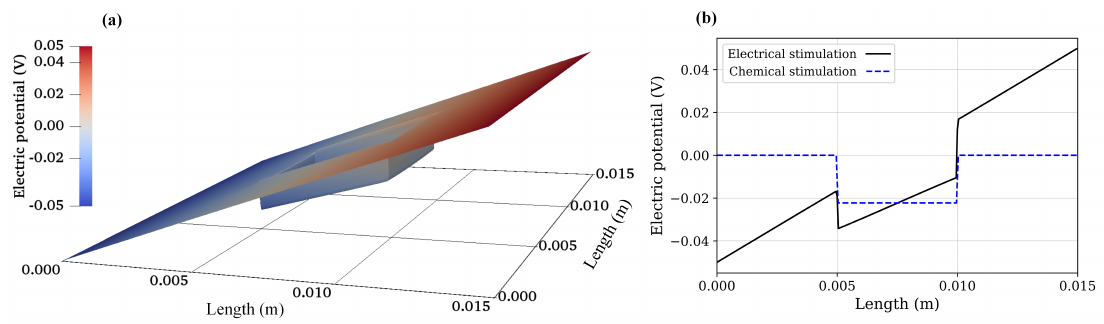
Figure 5. Anion concentration: ( a ) 2D electrical stimulation, ( b ) comparison of chemical and electrical stimulation versus x -position at y = 0.0075m.